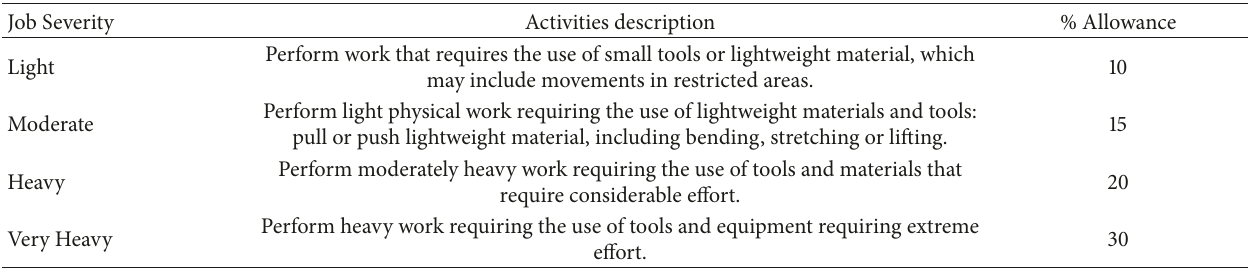
Table 4: Allowance percentage taken from AHMSA manual